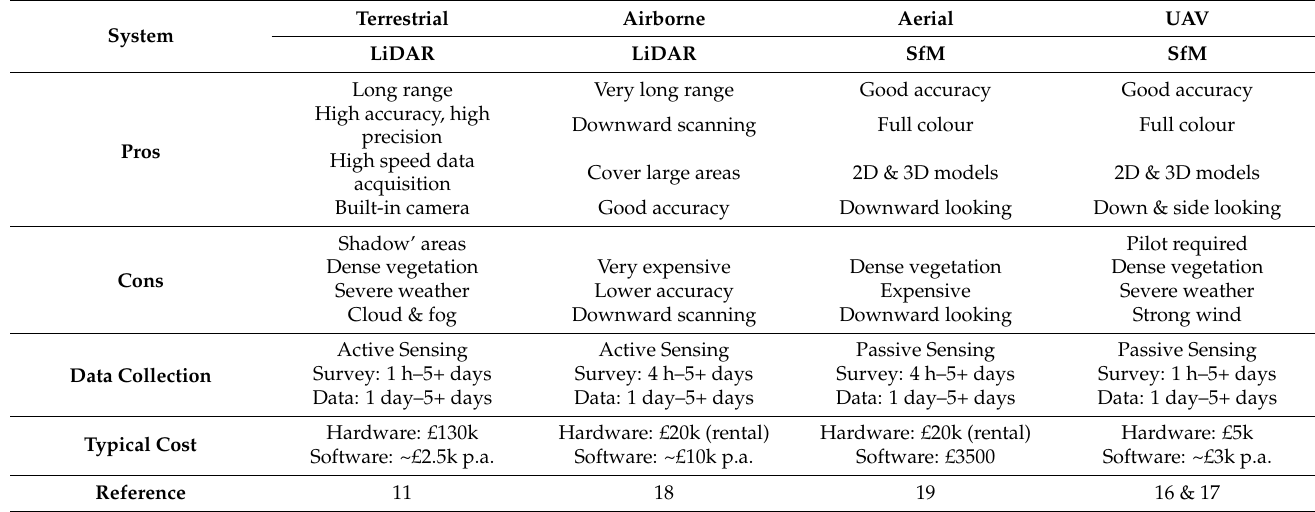
Table 1. Pros and cons of geodetic